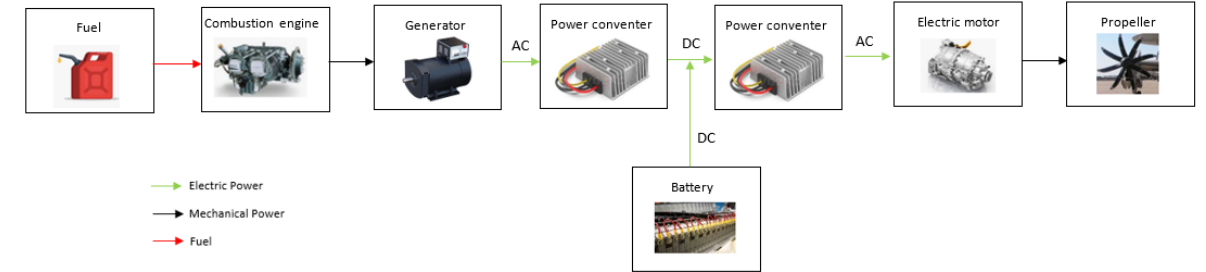
Figure 2. Serial hybrid architecture. Source: Processed by authors.